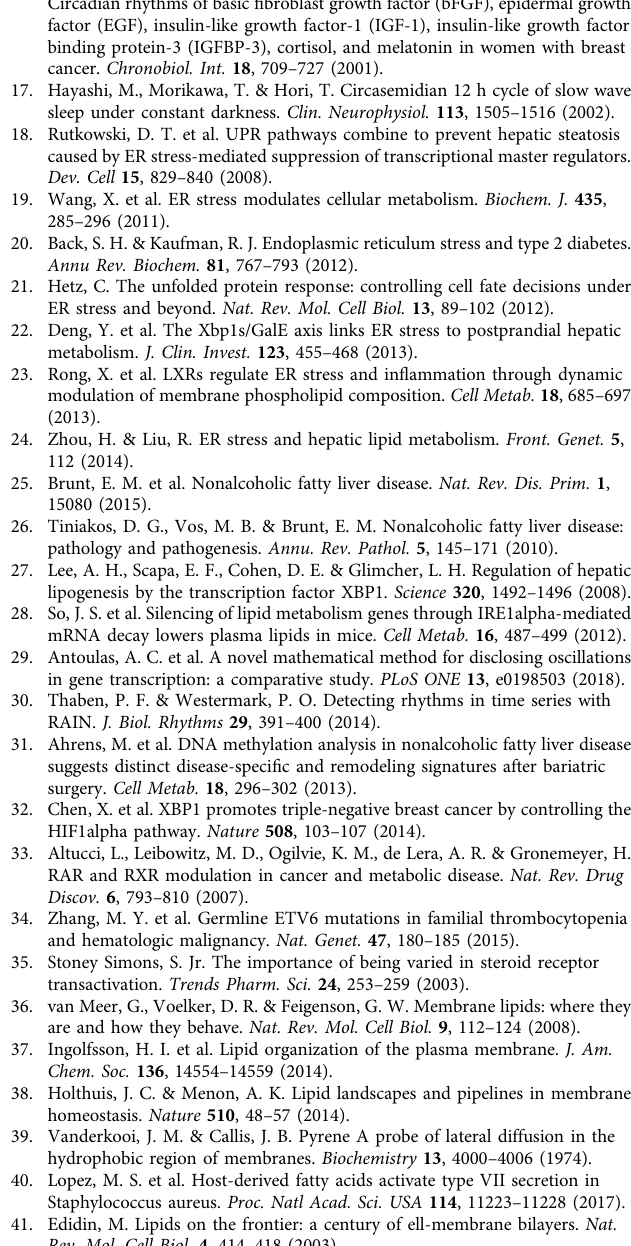
Fig. 7 Disruption of the liver-speci fi c 12-h clock abolishes 12-h oscillation of respiratory exchange ratio (RER). a , b The raw ( a ) and relative ( b ) real- time RER values of the indicated mice ( n = 4) housed under ad libitum feeding conditions. Individual (light line) and averaged (bold line) real-time RER values of the indicated mouse strains plotted against the indicated time points. c Eigenvalue/pencil decompositions and deconvolutions of the mean RER oscillations of 12-h (upper panel) and 24-h (lower panel) oscillations . d The relative frequency histogram (left panel) and raw values (right panel) of real- time RER of the indicated mice housed under ad libitum feeding conditions ( n = 4). e , f The raw ( e ) and relative ( f ) real-time energy expenditure (EE) values of the indicated mice ( n = 4) housed under ad libitum feeding conditions. Individual (light line) and averaged (bold line) real-time EE values of the indicated mouse strains plotted against the indicated time points. g The ANCOVA analysis (generalized linear model, GLM) of the real-time EE in ( e , f ). normalized by lean mass at the indicated light, dark, and full-day conditions ( n = 4). h The body composition of the indicated mice ( n = 9) housed under ad libitum feeding conditions. Unpaired Student ’ s t -test and one-way ANOVA analysis were performed with p value indicated. i The integrated statistical analysis is shown for the indirect calorimetry experiments of the Xbp1 fl x/ fl x and AlbCre;Xbp1 fl x/ fl x mice ( n = 4) housed under ad libitum feeding conditions. One-way ANOVA analysis with Tukey ’ s post hoc analysis was performed with p value threshold 0.05. Blue line : Xbp1 fl x/ fl x ; red line: AlbCre;Xbp1 fl x/ fl x . Mouse RER and EE data are graphed as the mean ± SEM. * p < 0.05, ** p < 0.005, *** p < 0.001, **** p